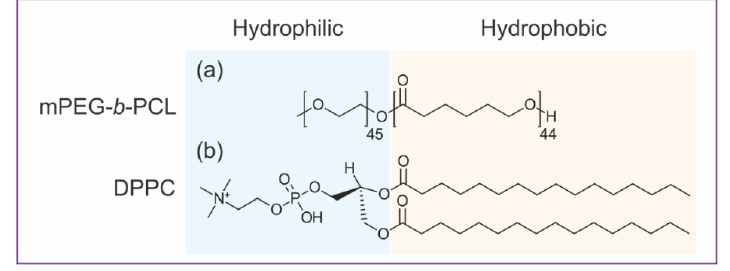
Figure Figure 1. Amphiphilic structures of hybrid giant vesicles components: ( a ) Methoxy poly(ethylene glycol)- block - poly(ε -caprolactone) 2k- b -5k g/mol (mPEG- b -PCL) diblock copolymer ( b ) 1,2- dipalmitoyl-sn-glycero-3-phosphocholine (DPPC) lipid.